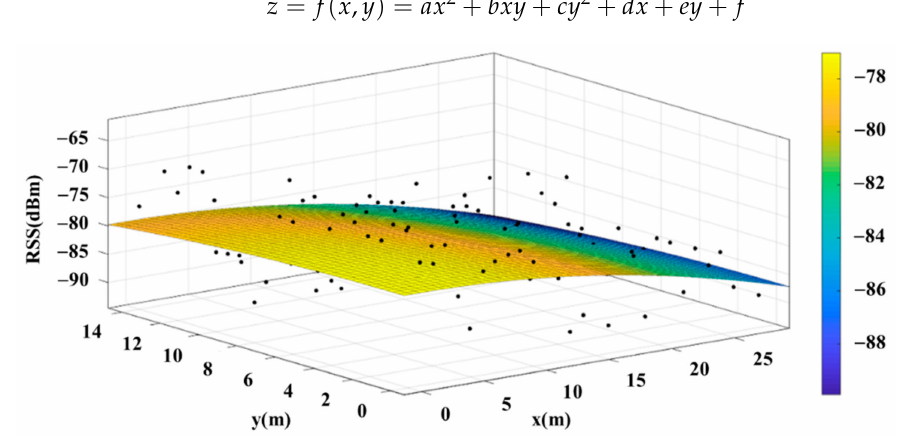
Figure 24. Model Generated Using Simplified Surface Equations.